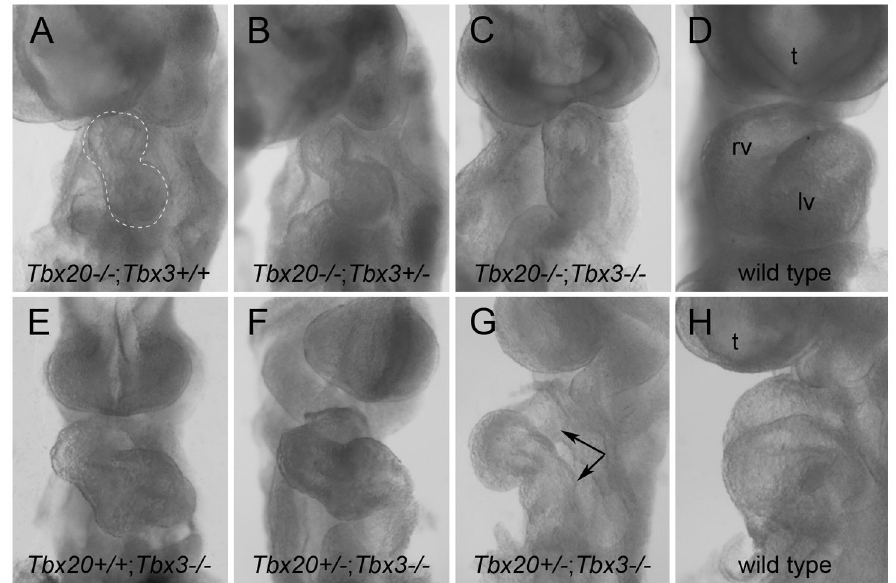
Figure 1. Tbx20 -/- ; Tbx3 -/- double homozygotes show heart defects similar to Tbx20 -/- embryos. Whole mount ventral (A–F) and left side (G, H) views of the heart (E9.25; 15-20 somite embryos) of Tbx20; Tbx3 single, compound and double mutants compared with wild type (D, H). All Tbx20 -/- embryos have an unlooped, hourglass-shaped heart (A-C, outlined in A), whereas Tbx3 -/- embryos either wild type or heterozygous for Tbx20 (E, F, G) have normally looped hearts but show atrioventricular convergence defects (G, arrows) compared with wild type (H). lv, left ventricle; rv, right ventricle; t, telencephalon. doi: